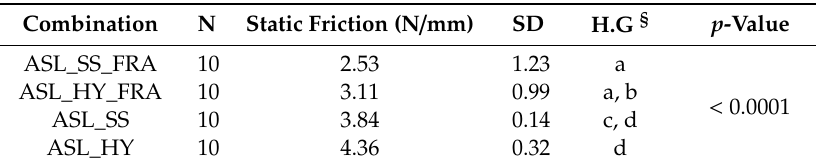
Table 4. Static friction values in metallic active self-ligating brackets (ASL). The letters show significance statistical di ff